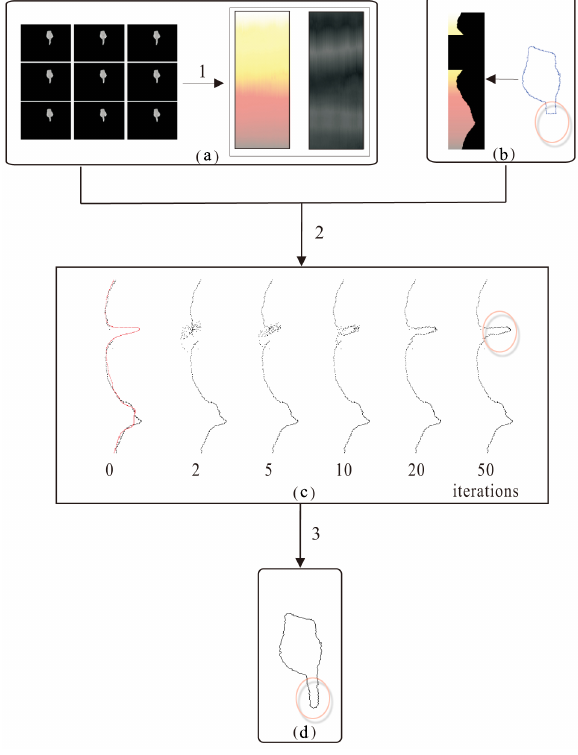
Figure 9: Estimation of missing data by using PCA. (a) shows the 1D signatures matrices of angles (color image on the left) and distances (black and white image on the right) from 74 pointing hand form samples. Each column of the matrices corresponding to a template sample (see Section 2.3.1). (b) is a given incomplete